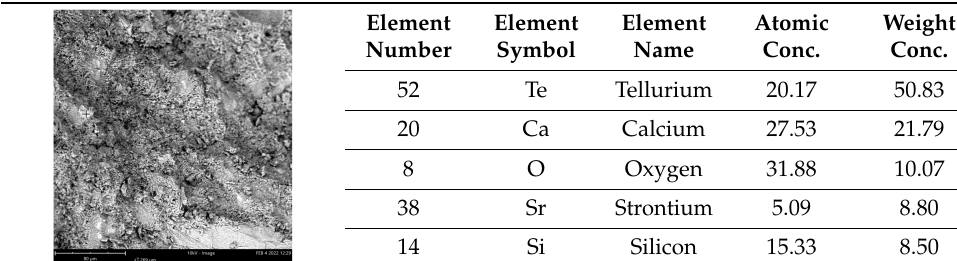
Table 14. SEM-EDS result for Y 3 concrete sample spot.